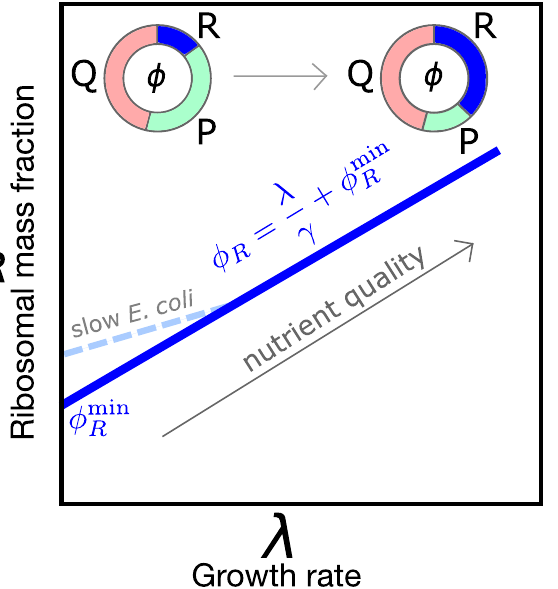
Fig 1. Sketch of the growth law relating ribosome mass fraction ϕ to growth rate λ . The fraction of ribosomal and R ribosome-affiliated proteins (R) increases with increasing nutrient quality at the expense of the sector of metabolic proteins (P), while a fraction of the proteome (Q) is kept to be growth rate-independent. Available data for most > 0 (see S1 Fig). In E. coli [5], the law deviates from linearity at slow growth organisms show a nonzero intercept � min R ( λ � 1 h − 1 ), making the intercept � min R